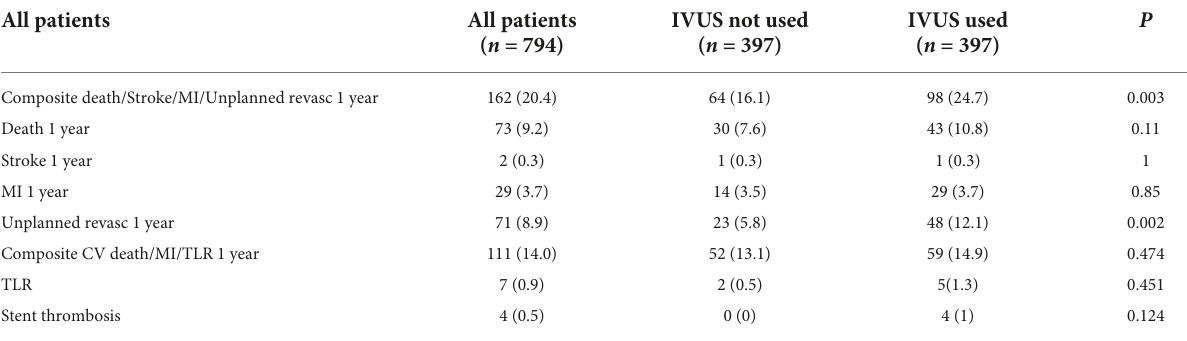
TABLE 4 Outcomes for propensity-matched patients. Outcomes in propensity matched patients All